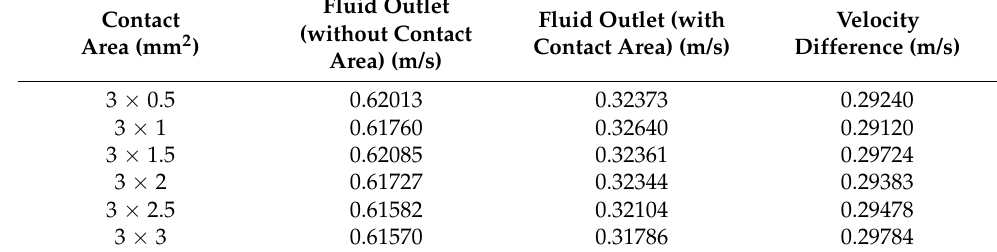
Table 4. Velocity variations in the two bifurcated fractures for different contact areas (cross-section is 3 mm).